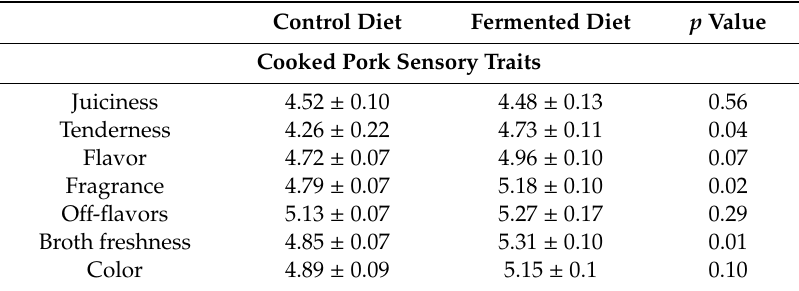
Table 6. Sensory traits evaluation of grilled longissimus thoracis